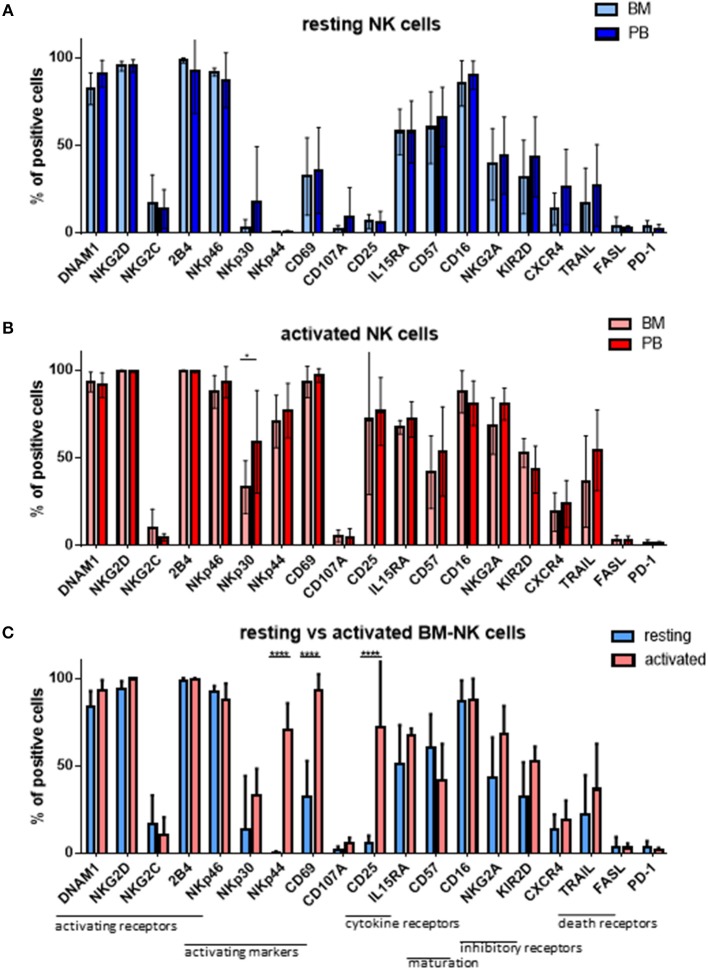
NK cells isolated from peripheral blood or bone marrow exhibit a similar cytotoxic potential and phenotype. The phenotypes of (A) resting and (B) activated NK cells isolated from peripheral blood and bone marrow of patients at TP0 were compared by staining with fluorochrome-conjugated antibodies. (C) Comparison of the BM NK phenotype before and after activation. For bone marrow samples, 7 individual experiments with resting NK cells and 4 individual experiments with 7 days cytokine activated NK cells were performed (n = 4–7). For peripheral blood samples, 14 individual experiments with resting NK cells and 15 individual experiments with activated NK cells were performed (n = 14–15). Statistical analysis with two-way ANOVA + Sidak's multiple comparison: *p < 0.05, **p < 0.01, ***p < 0.001, ****p < 0.0001.